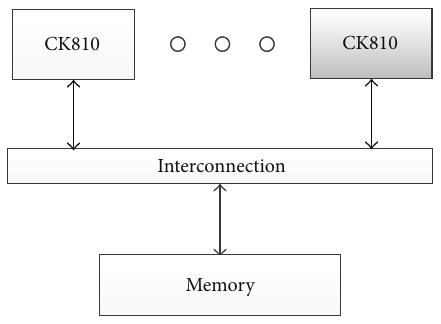
Figure 7: Architecture of